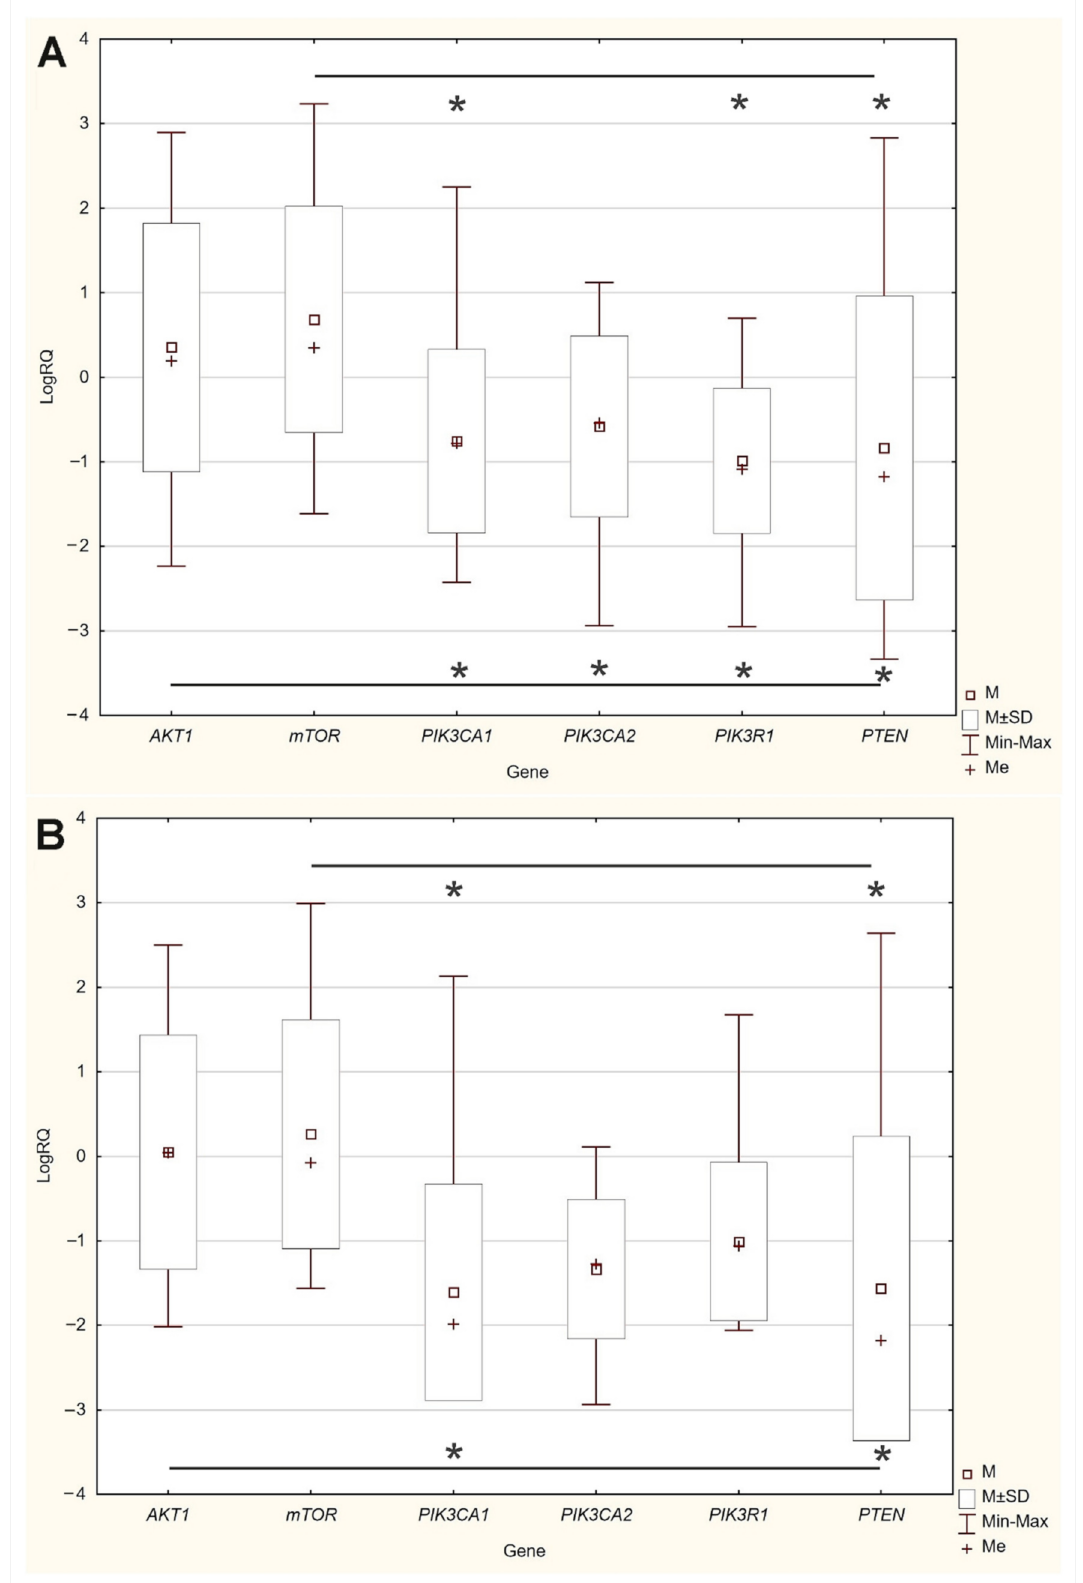
Figure 3. Differences between the expression level of the studied genes: ( A ) in the group of patients without mutations; ( B ) in the group of patients with mutations * p <